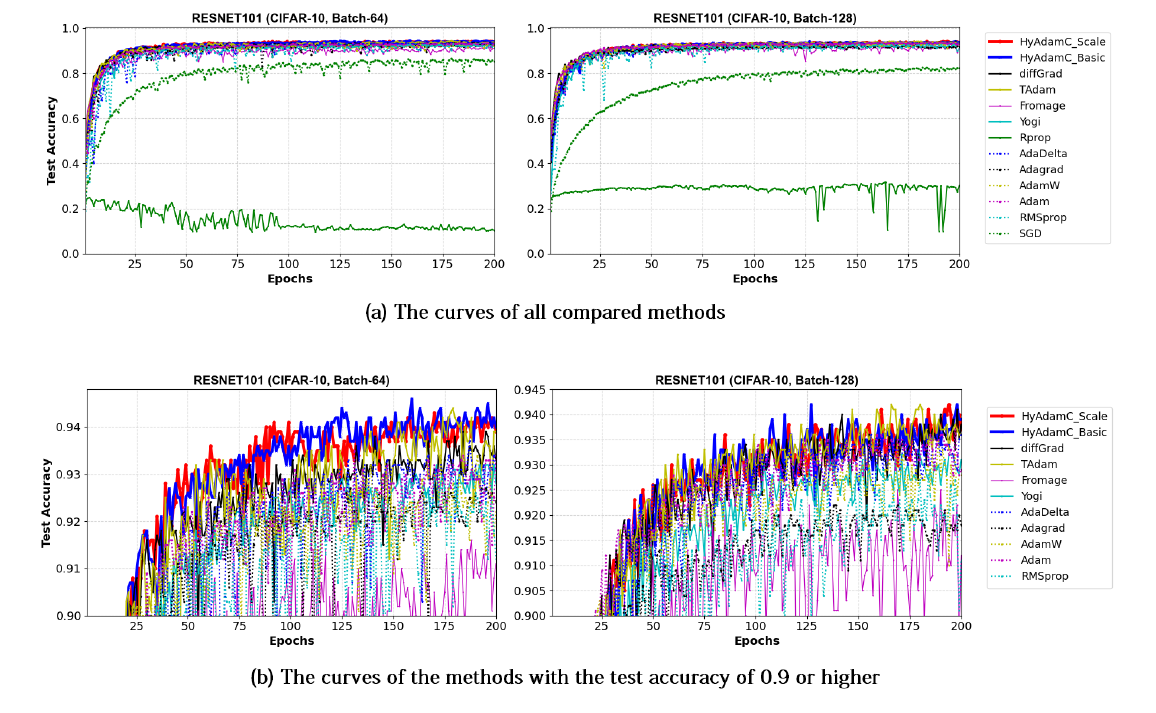
Figure 20. The test accuracy curves of the ResNet-101 trained by HyAdamC and other optimization methods in the CIFAR-10 image classification tasks. In this figure, ( a ) shows the test accuracy curves of all compared methods. On the other hand, ( b ) illustrates the plots in which a range of the y-axis of the plots described in ( a ) is zoomed into between 0.9 and 0.945.